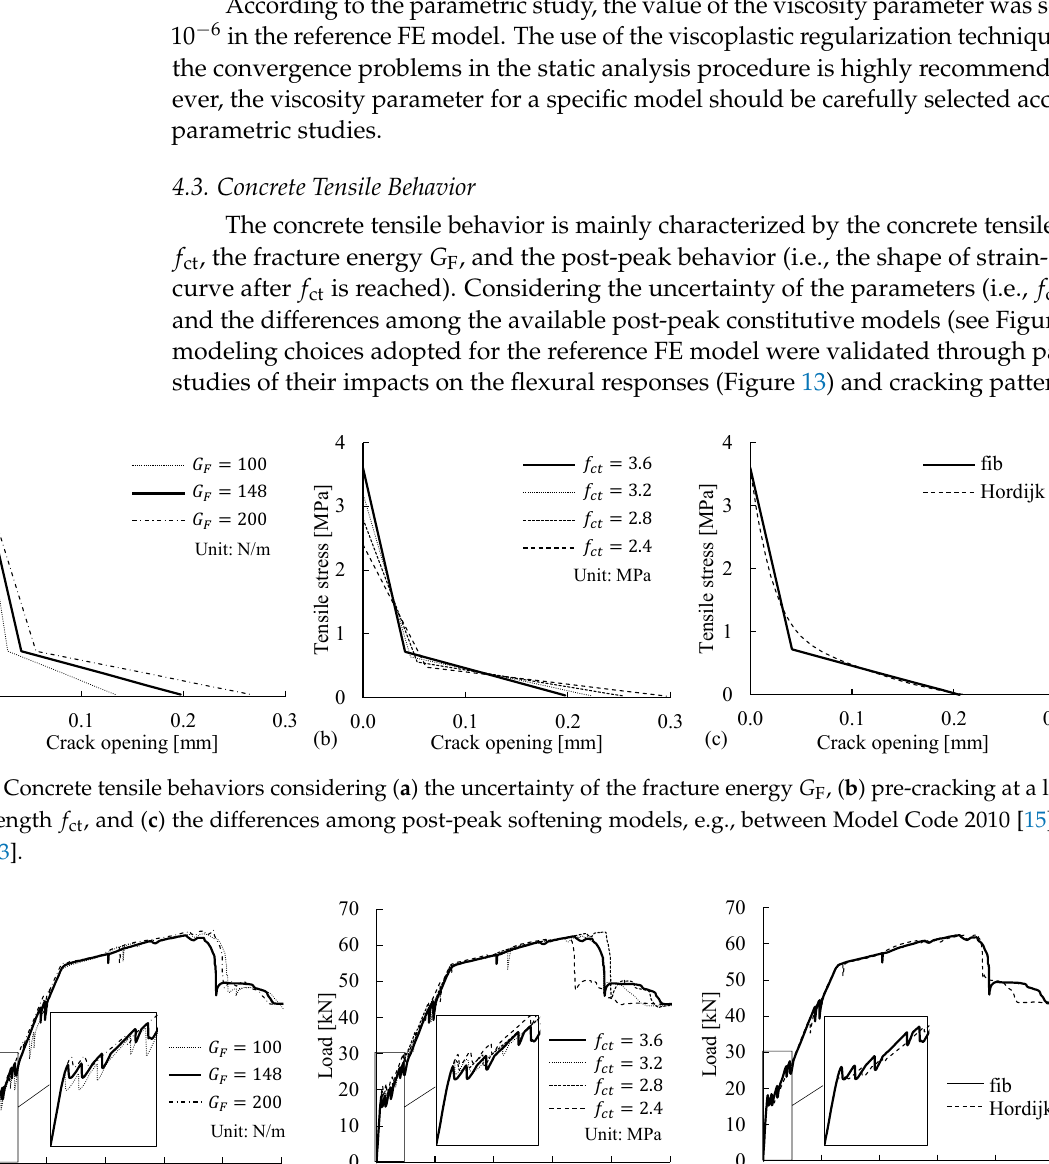
Figure 13. Numerical results for the load–midspan deflection relations obtained in the parametric studies on the modeling choices for ( a ) the fracture energy G F , ( b ) the tensile strength f